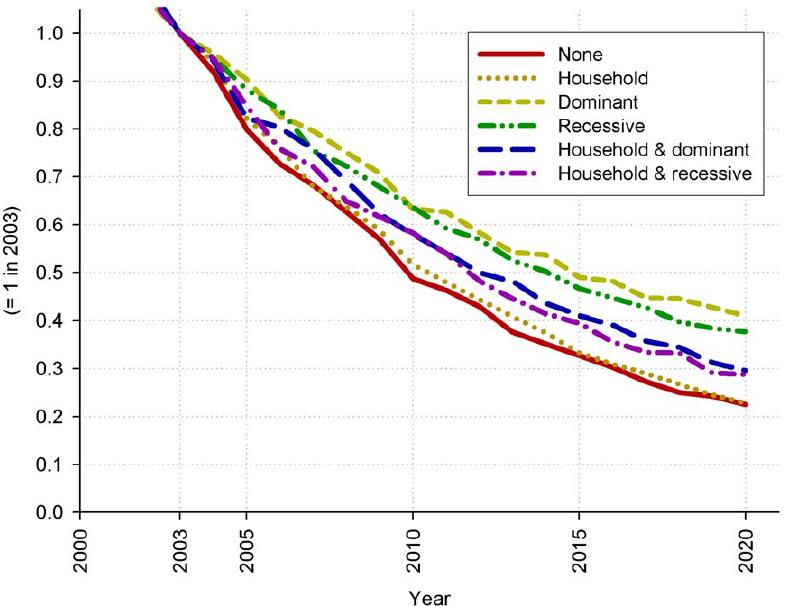
Figure 4. Trend in decline of the leprosy new case detection rate, relative to the new case detection rate in 2003 (value is 1 in 2003). The assumed fraction of susceptibles is 20% for Random and 10% for the other five mechanisms.